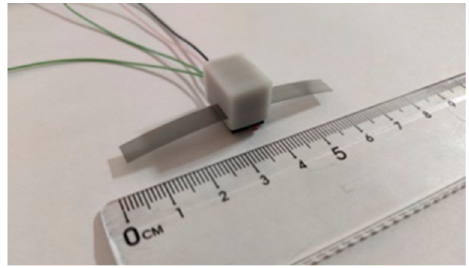
Figure 4. The picture of the designed sensing unit.